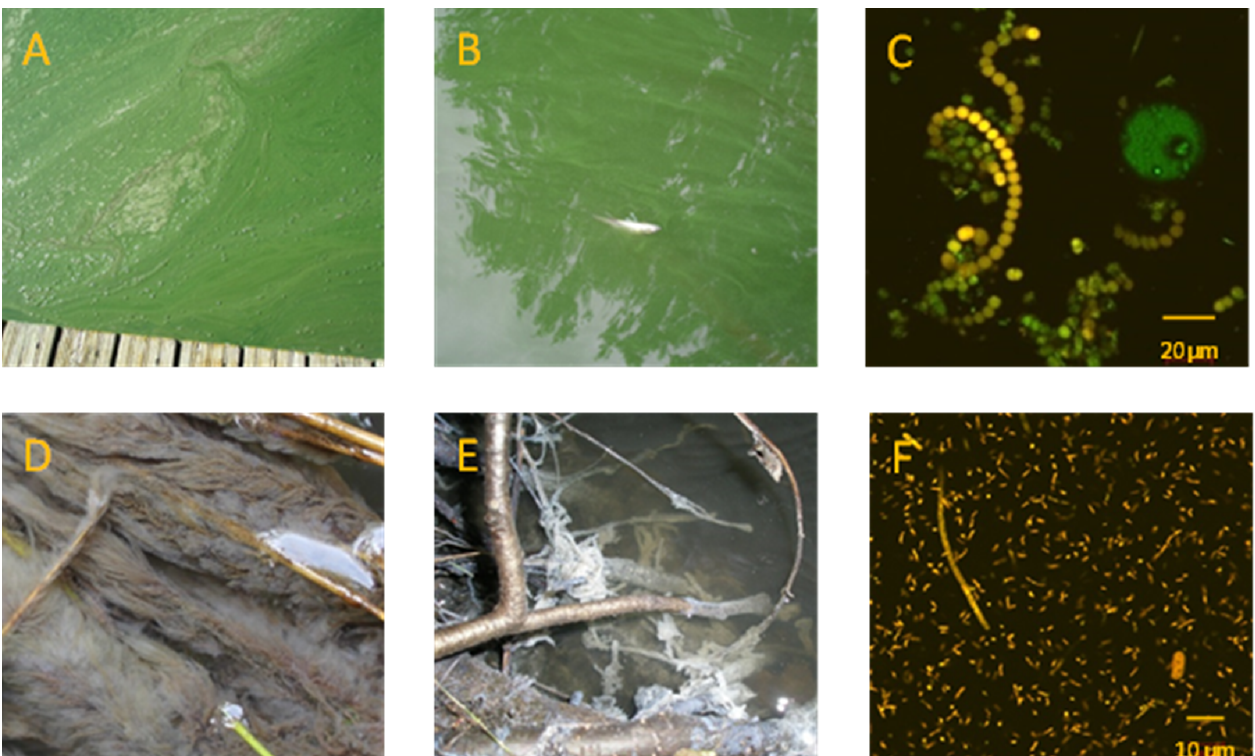
Figure 3. ( A , B ), Massive cyanobacterial bloom in Lake Seeburg (pier) in July 2018, with dead fish due to cyanobacterial toxins; ( B ), see planks (~12 cm) and dead fish (~15 cm) for scale; ( C ), Anabaena sp., dominating species in bloom 2017; ( D , E ), microbial filaments ( D ) and thick biofilms ( E ) of sulfide oxidizing bacteria (SOB), which covered all available substrates in the Aue creek in August 2017 (image widths ~15 cm); ( F ), high abundance of sulfur-cycling microorganisms (SRB, SOB, including proteobacteria (purple sulfur bacteria)) in the sulfidic creek water after the rain event 2017. SOB with S-globules (observed via confocal laser scanning microscope); according to the size and surface pattern of the large bacterium (right corner), it can be assigned to purple sulfur bacteria.